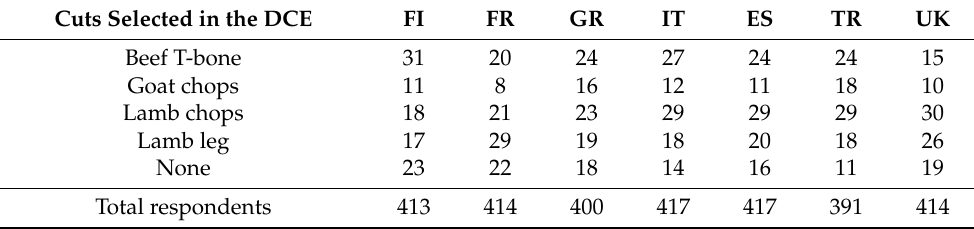
Table 4. Percentages of selected cuts in the discrete choice experiment (DCE) per country. Cuts Selected in the DCE